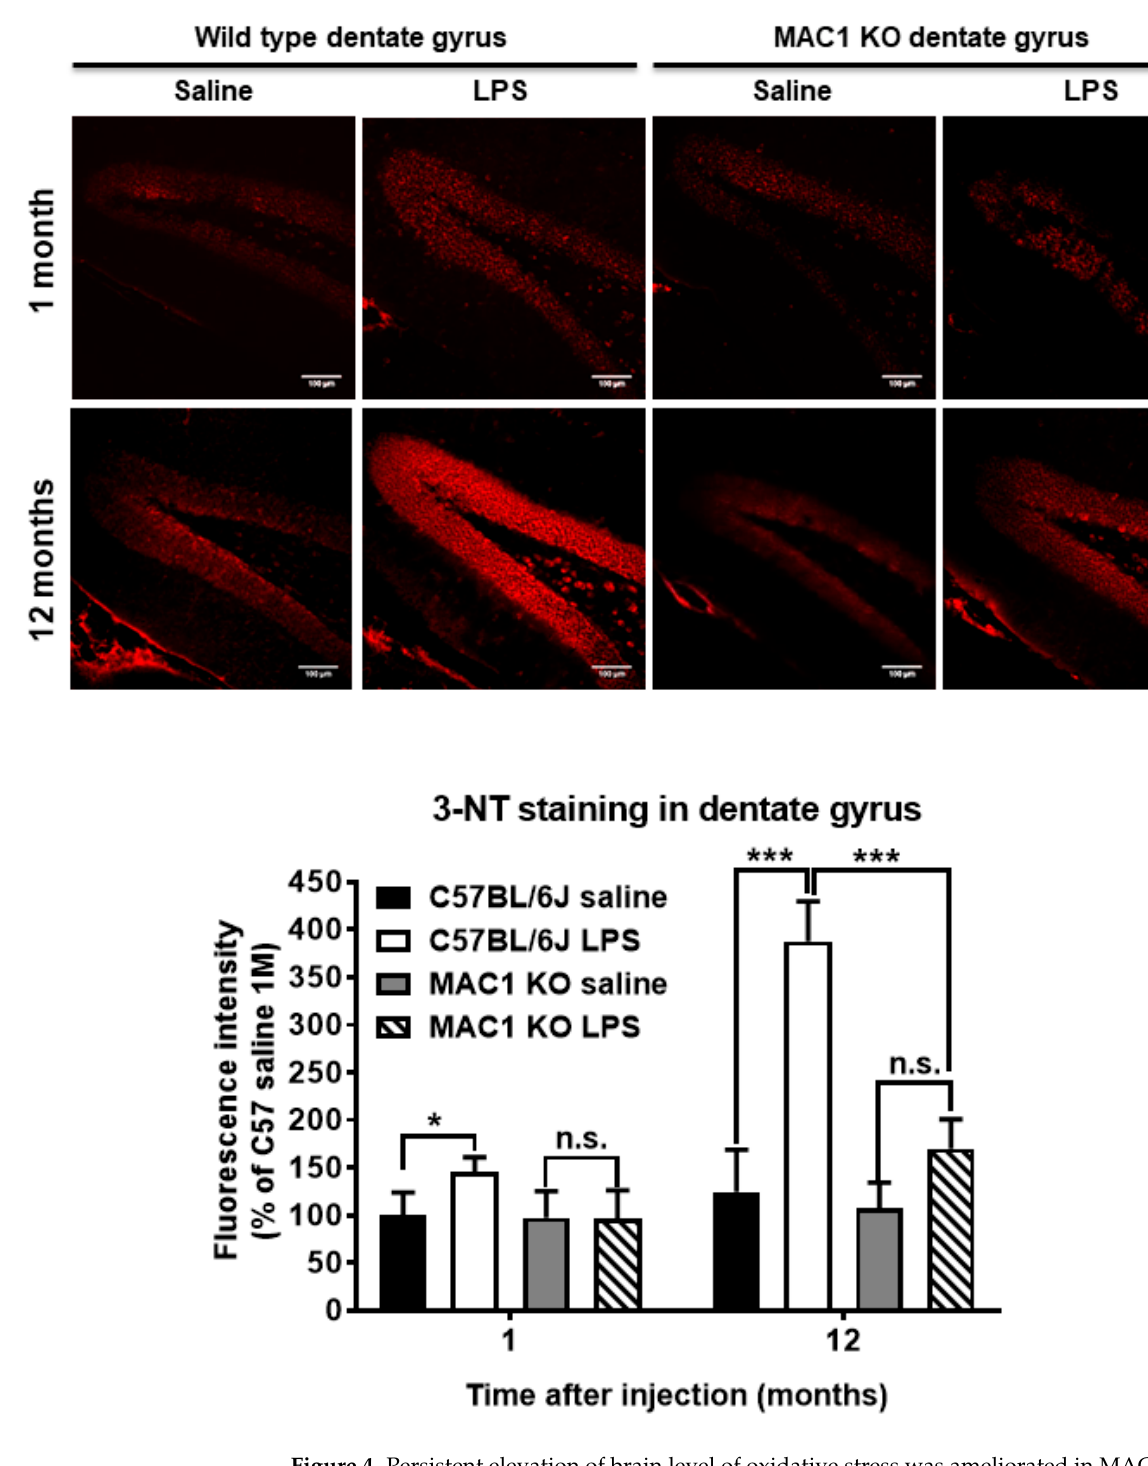
Figure 4. Persistent elevation of brain level of oxidative stress was ameliorated in MAC1 KO brains. Brain slides from C57BL/6J and MAC1 KO mice were collected at 1 or 12 months after saline or LPS injection (N = 3 in each group and time point). Three brain slides from each group were stained with 3-nitrotyrosine (3-NT), an oxidative stress marker. ( a ) 3-NT staining in substantia nigra and ( b ) hippocampal dentate gyrus. Scale bar in ( a ) = 50 μ m, in ( b ) = 100 μ m. * p < 0.05, *** p < 0.001.